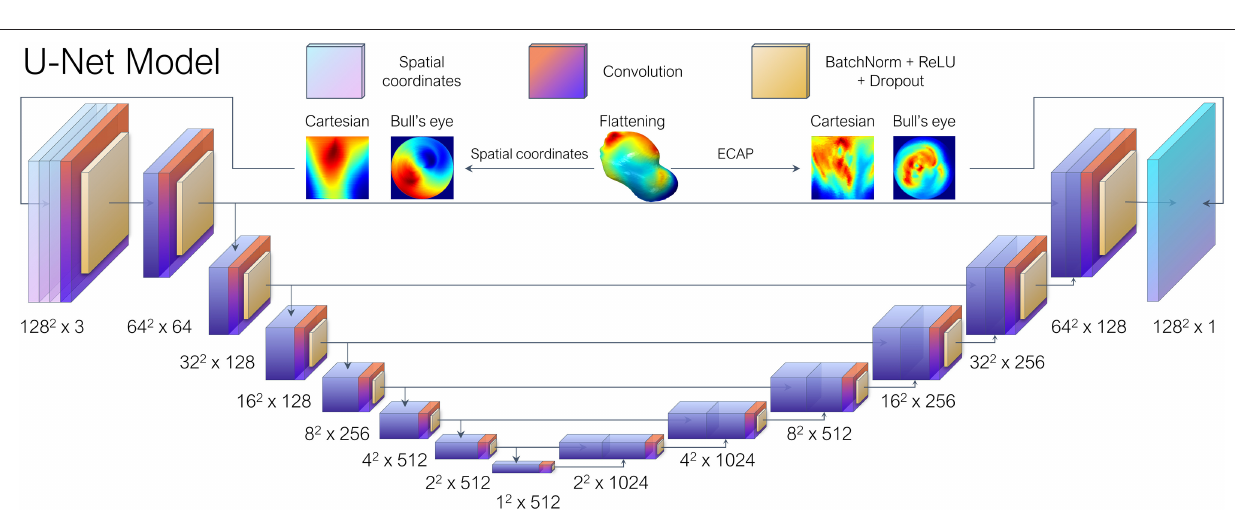
FIGURE 3 | Each left atrial appendage (LAA) went through UV mapping, more colloquially known as flattening, and represented as a 2D image either as Bull’s eye plot or a polar coordinate-based Cartesian grid representation. The U-Net architecture based on the work by Thuerey et al. (2020), received the spatial coordinates of the vertices sampled during the flattening process as the input features and then performed regression to predict their corresponding ECAP